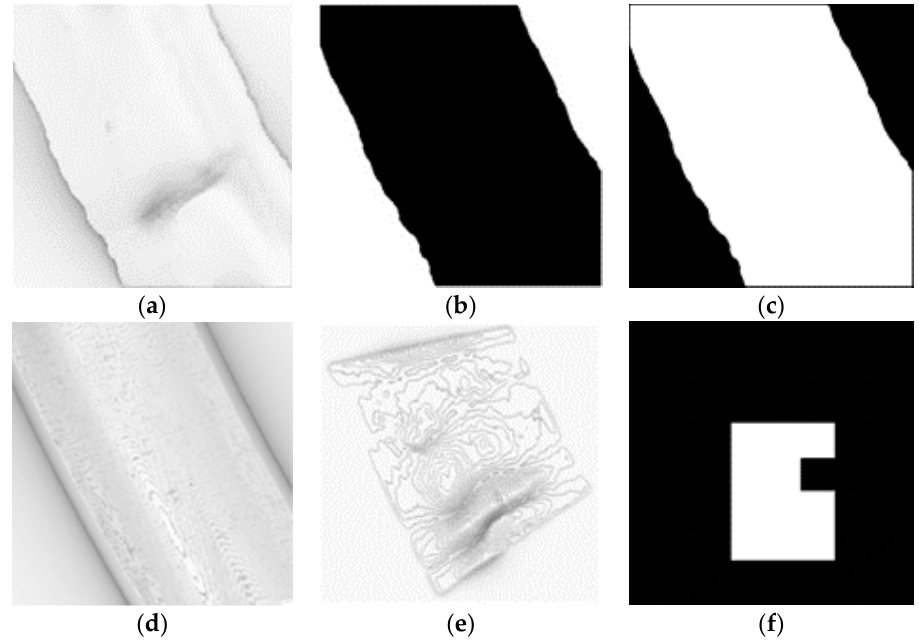
Figure 9. Each stage output of defect detection processing: ( a ) Model of photometric stereo produce; ( b ) I 6 , this image capture with the button light source in defect detection mechanism (Figure 3); ( c ) binarization and inverse image of ( b ); ( d ) smooth model M S , created by Figure 5; ( e ) result of ( d ) subtracted from ( e ); ( f ) candidate defect area, which create by sliding windows.